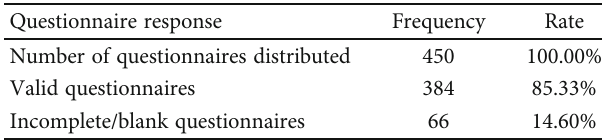
Table 2: Survey response